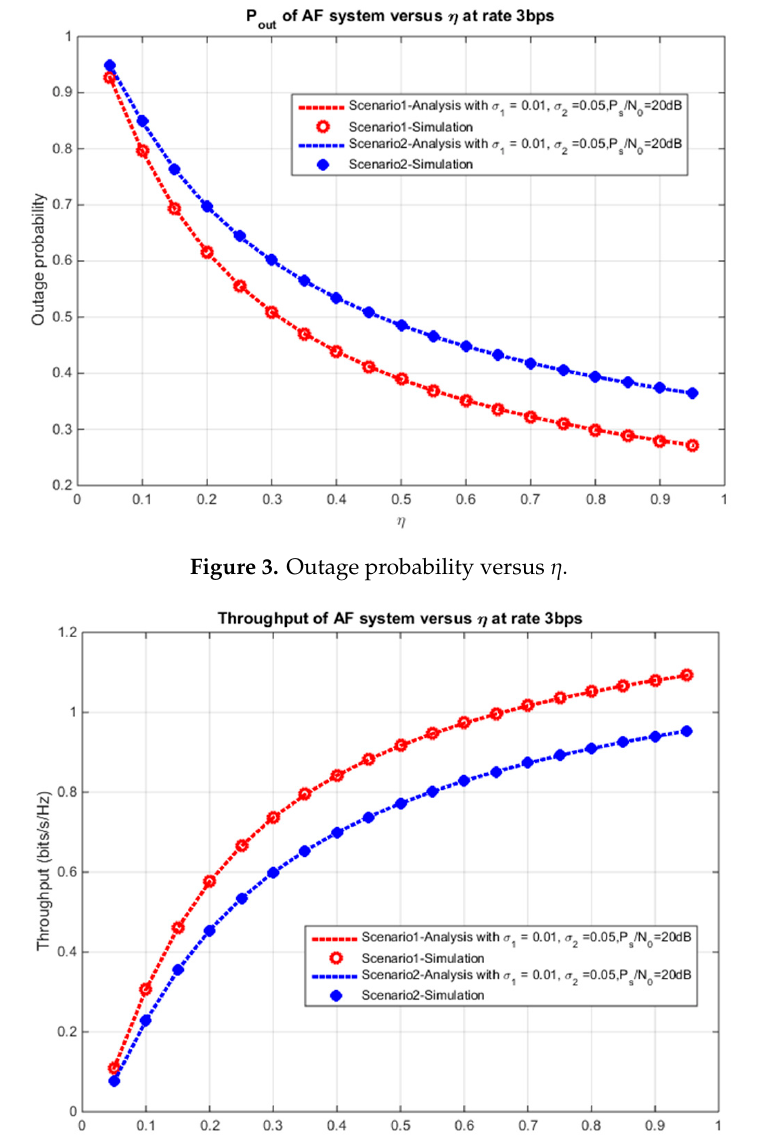
Figure 5. The outage probability versus ratio of P s / N 0 .